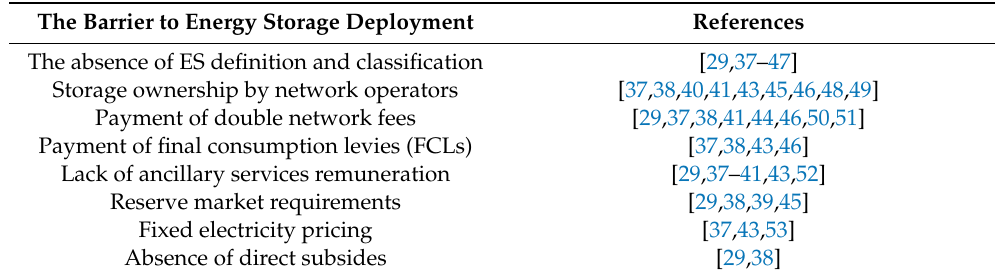
Table 1. The main regulatory and market barriers for Energy Storage deployment in the EU /